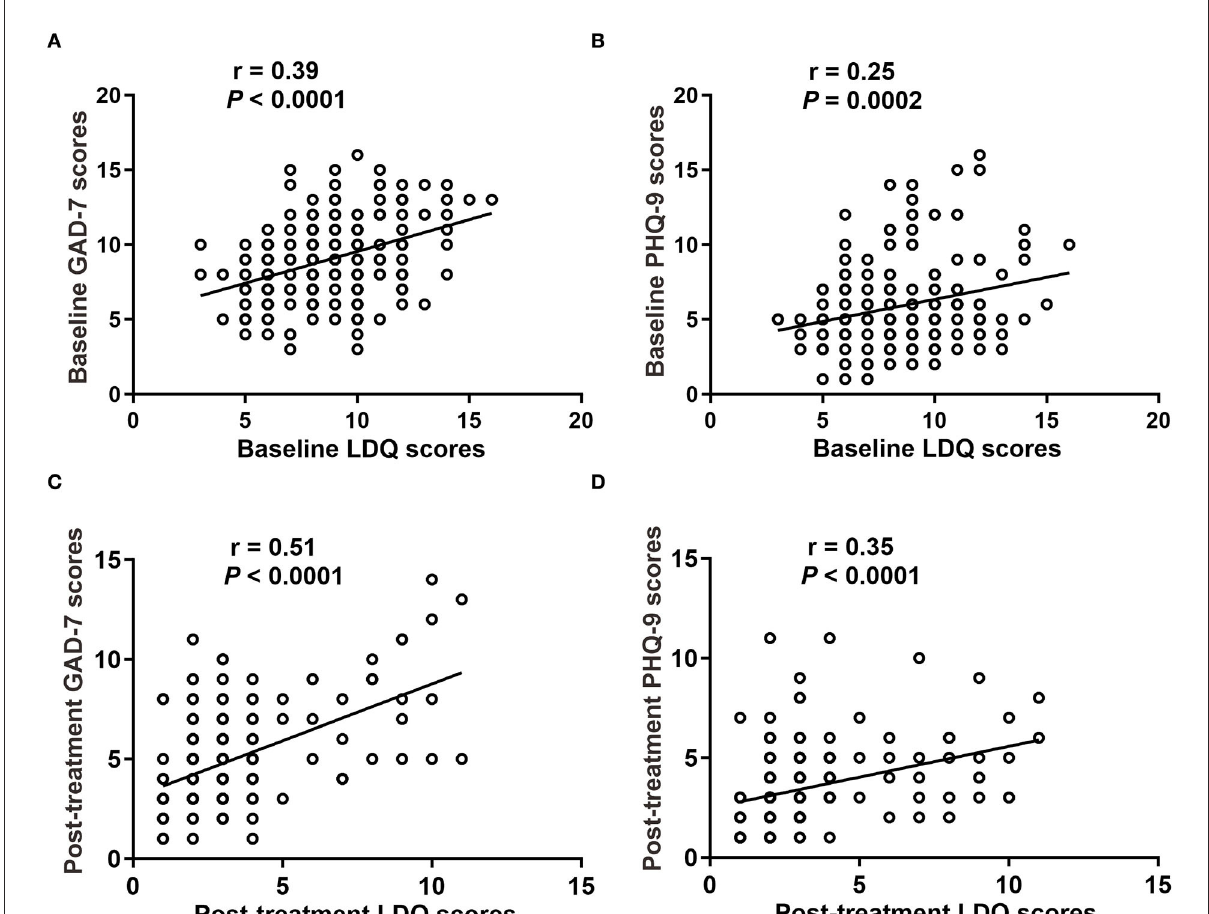
FIGURE4 Correlation between dyspepsia symptoms with emotional disorders. (A) Baseline GAD-7 scores with LDQ scores. (B) Baseline PHQ-9 scores with LDQ scores. (C) Post-treatment GAD-7 scores with LDQ scores. (D) Post-treatment PHQ-9 scores with LDQ scores. LDQ, Leeds